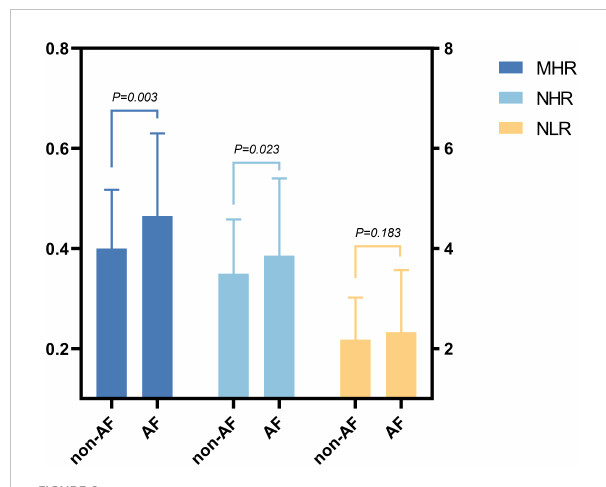
FIGURE 2 In fl ammatory characteristics of patients in AF and non-AF